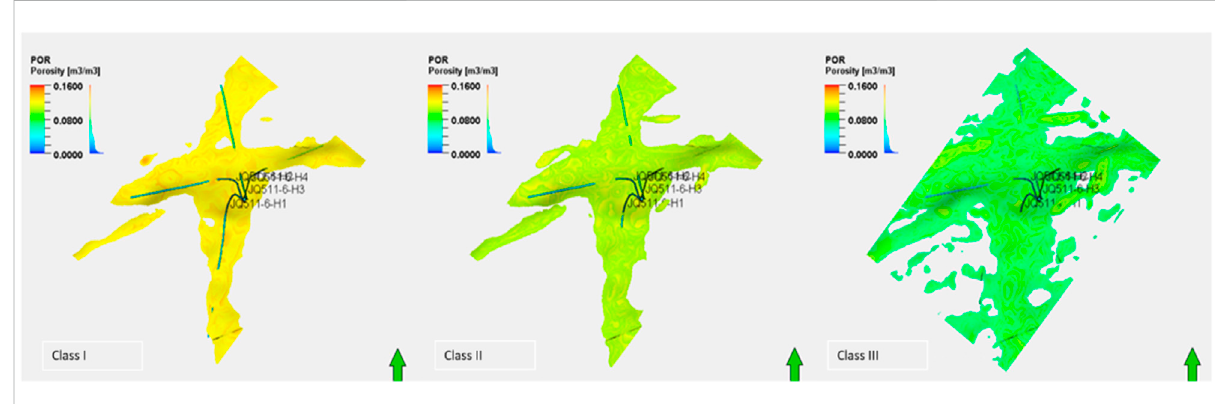
FIGURE 10 Distribution of different types of reservoirs in JQ511 platform model.